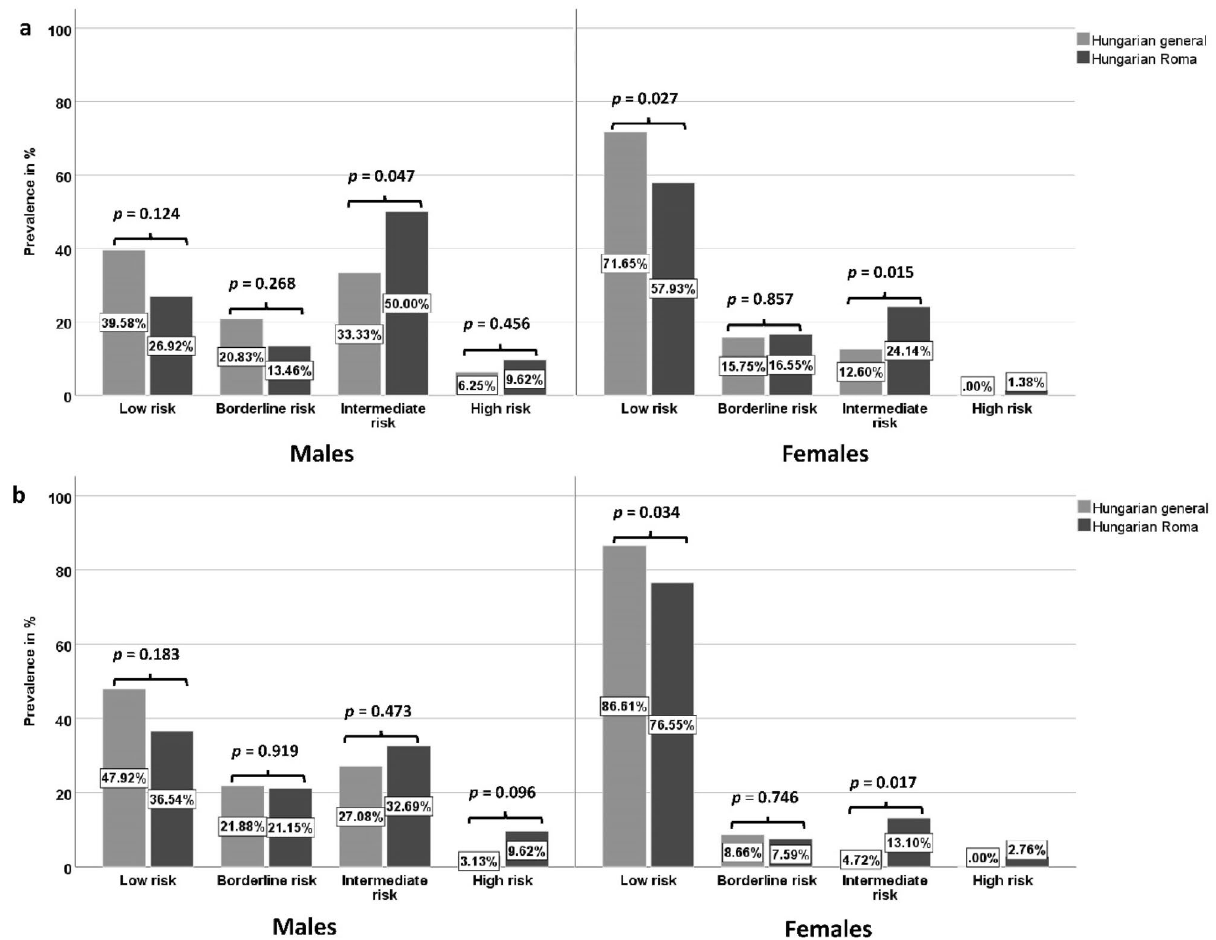
Figure 4. Distribution of subjects by risk categories defined by ACC/AHA pooled cohort equations (PCE-a) and revised pooled cohort equations (RPCE-b) in the 40–64-year-old Hungarian general and Hungarian Roma